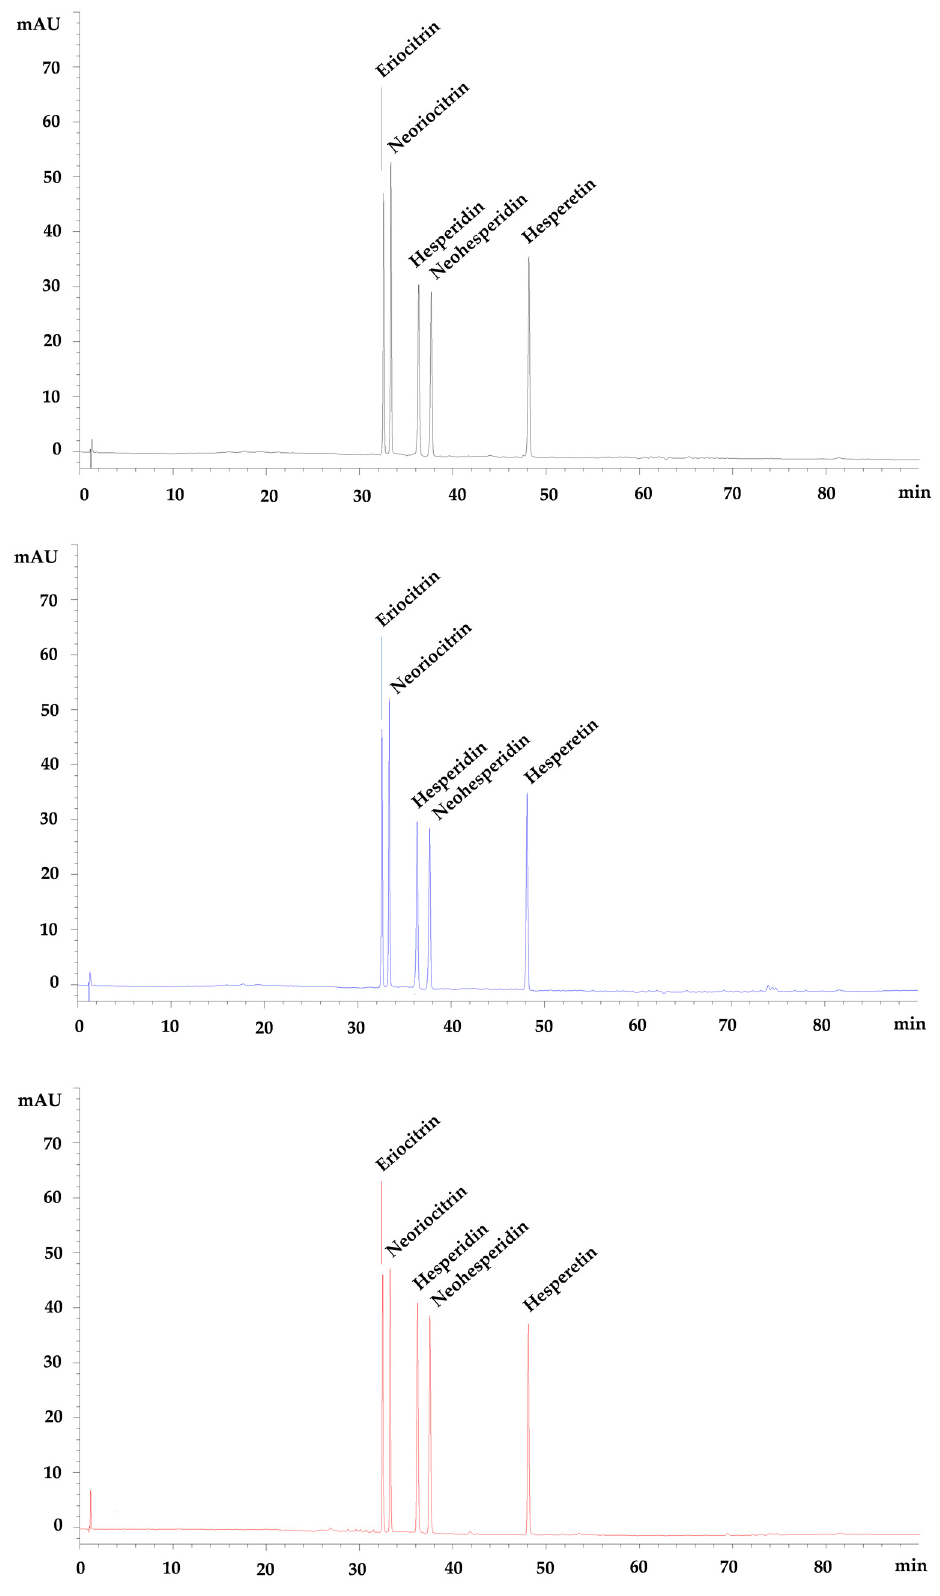
Figure 4. Representative LC-DAD chromatograms of flavanones mix ( black ), gastric digested flavanones mix ( blue ) and duodenal digested flavanones mix ( red ) acquired at 292 nm.